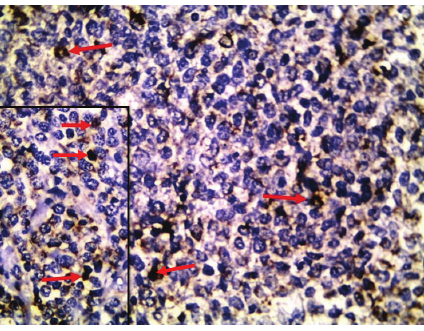
Figure 2: The malignant lymphocytes showed positive nuclear staining (arrows) of SV40 in a case of DLBCL. Inset closer view of nuclear staining of SV40 (arrows) (IHC ×